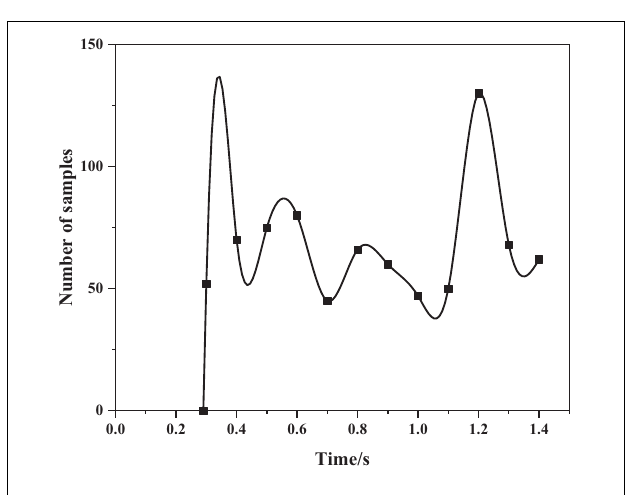
FIGURE 4 | The pitch frequency of anger emotion.